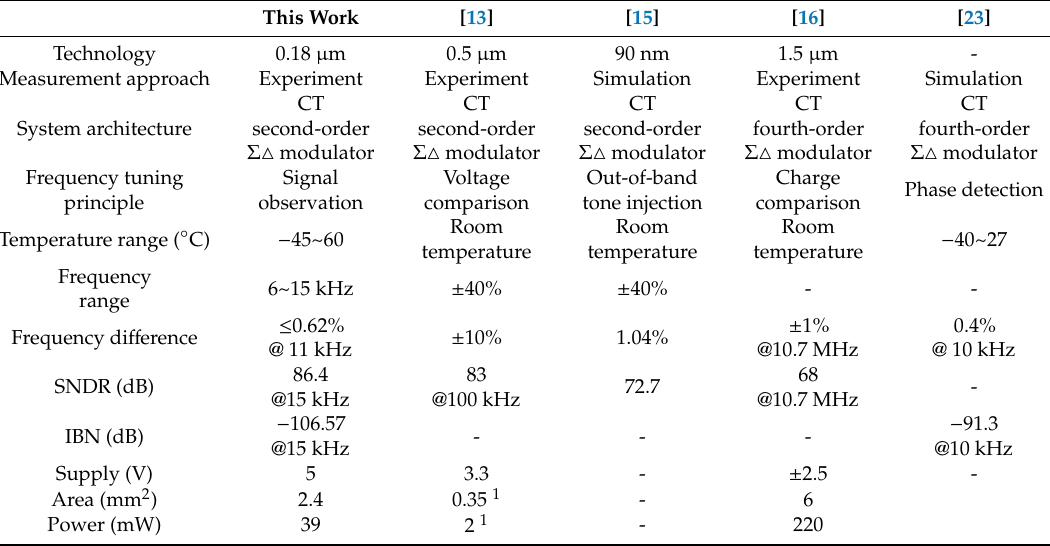
Table 3. Performances summary and